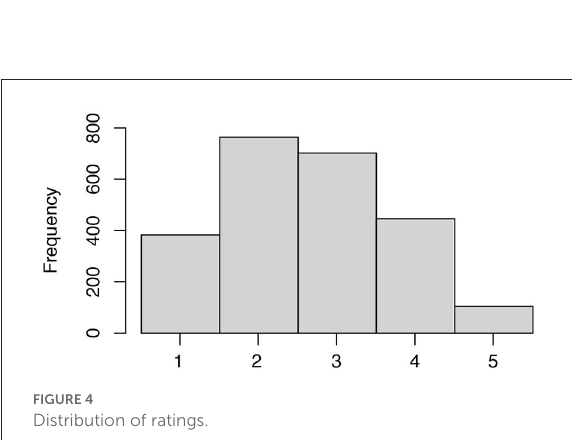
FIGURE4 Distribution of